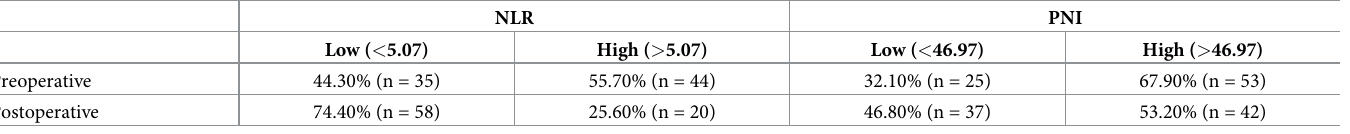
Table 2. Low and high NLR and PNI group